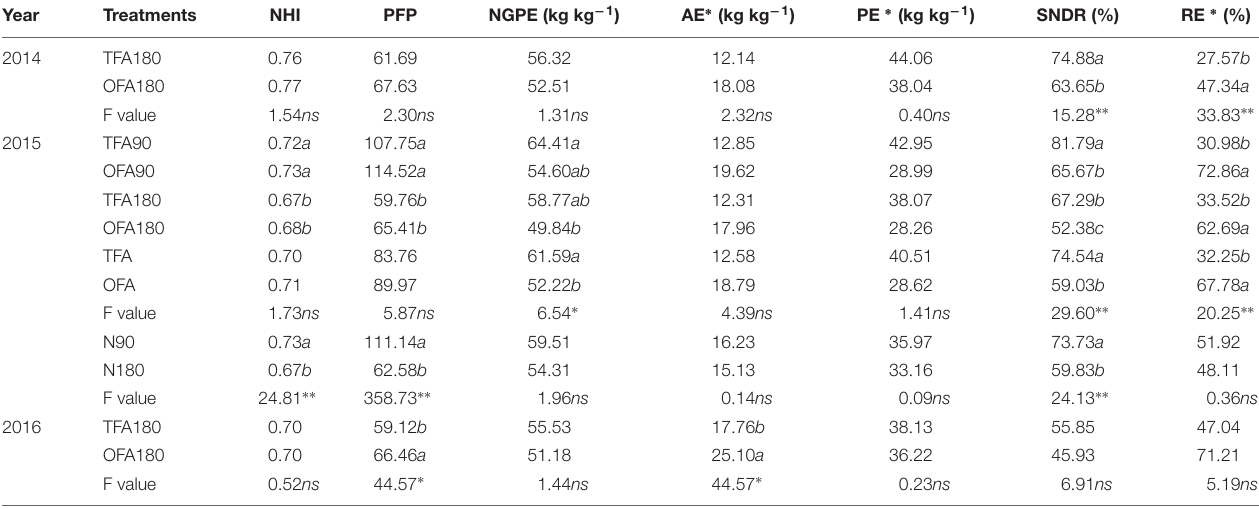
TABLE 4 | Nitrogen utilization efficiency in the various treatments.